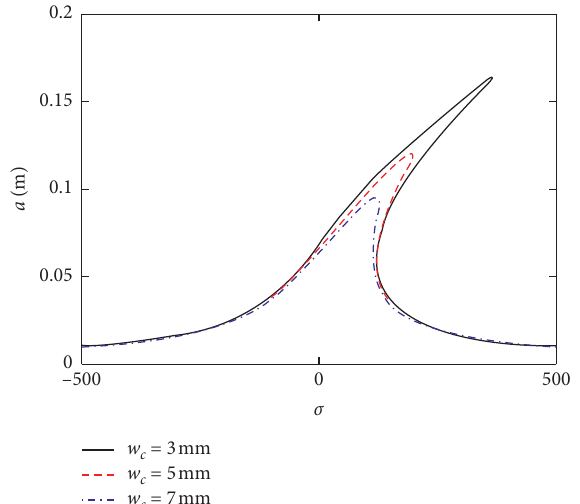
Figure 14: Effect of the cutting depth on primary resonance curves.